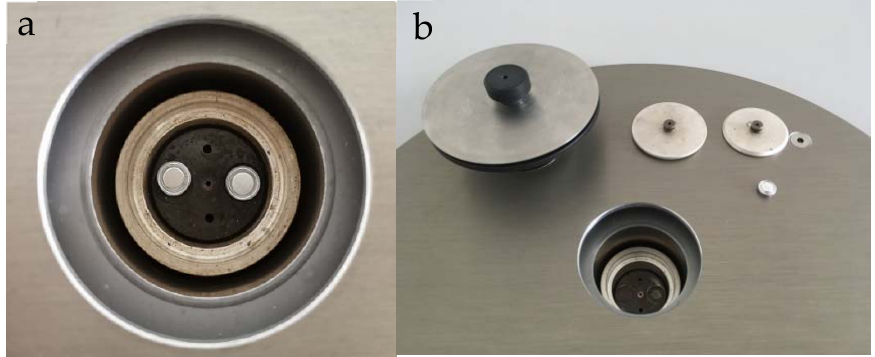
Figure 3. Schematic diagram of step cooling experimental system. 1—Computer; 2—Beaker; 3—Thermal insulation layer; 4—Cryogenic tank; 5—Thermocouple; 6—Data collector